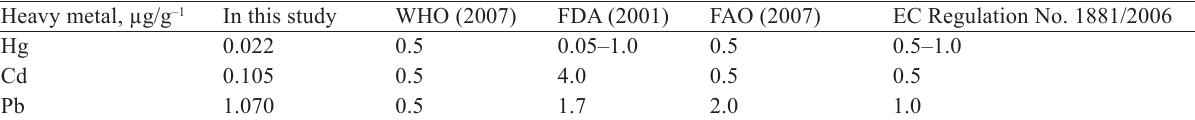
Table 1 Maximum permissible limit of heavy metals established by international organisations Heavy metal, µg/g –1 In this study WHO